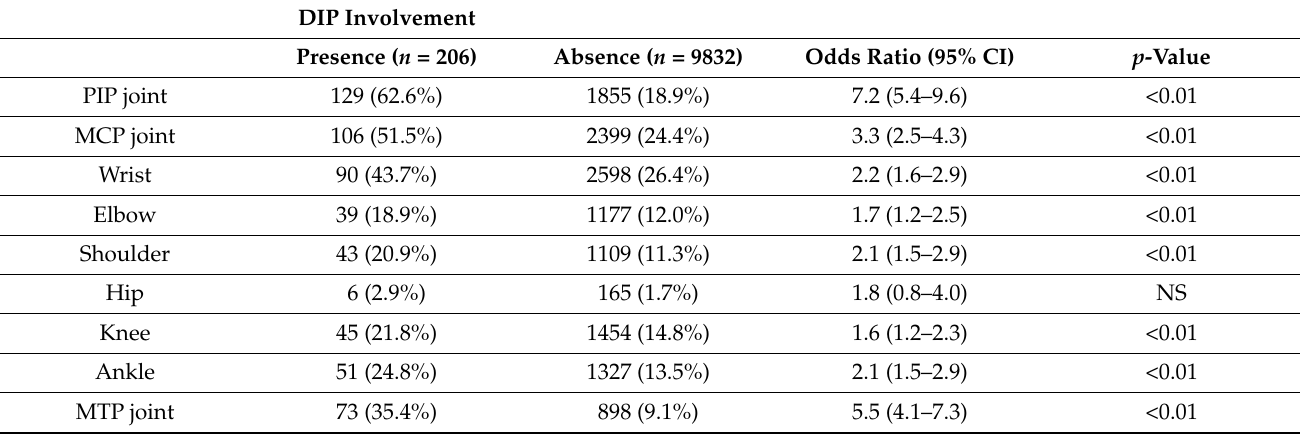
Table 3. Percentage of symptomatic involvement and odds ratios for non-distal interphalangeal (DIP) joints according to the presence or absence of DIP joint